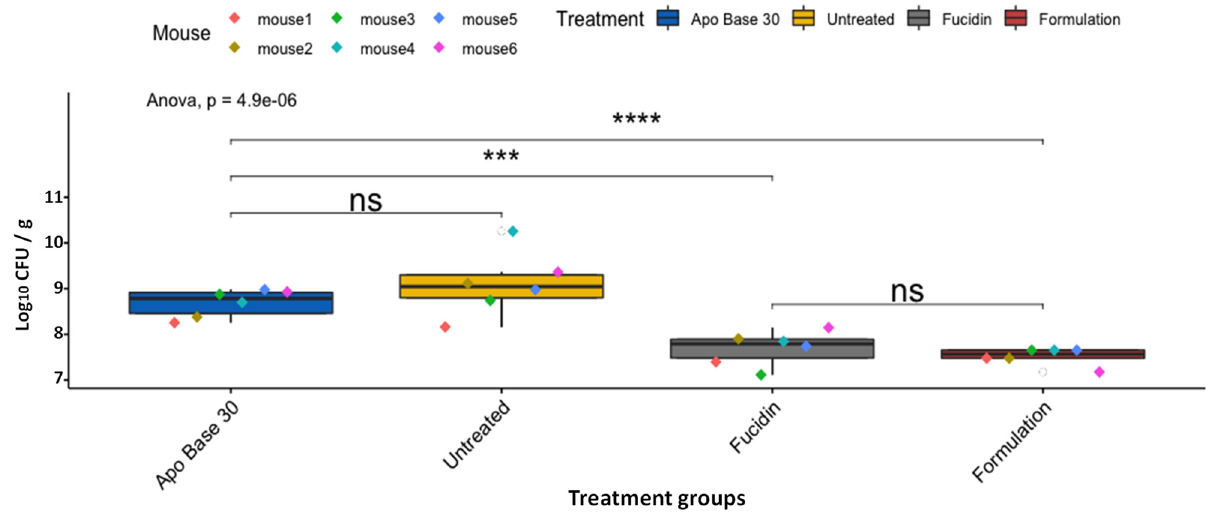
Figure 3. Box plots of CFU counts (CFU/g) of LMGT 4219 from skin tissue samples in differently treated mouse groups after four treatments. The area within each box represents the interquartile region (IQR), which comprises the second and third quartiles and describes the interval of values in which the middle 50% of the observed data are distributed. The horizontal black line within each box represents the median value. The extent of the IQR (box height) expresses the degree of variability measured within the middle 50% of the observed data, with whiskers extending out at either side of the boxes to mark minimum and maximum observed values as well as variability outside the middle 50% of values (whisker length). Outliers are displayed as data that extend out of the whisker limit (1.5 times the IQR). There were six mice in the untreated group. Pairwise statistical analyses were performed using the unpaired two-sample t-test. *** p < 0.001; **** p < 0.0001; ns = not significant.